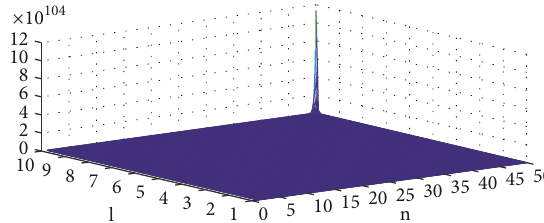
Figure 11: Influences of 𝑛 and 𝑙 on 𝜃 (set 𝑛 𝑙 / |𝑆𝑒𝑙𝑓| =